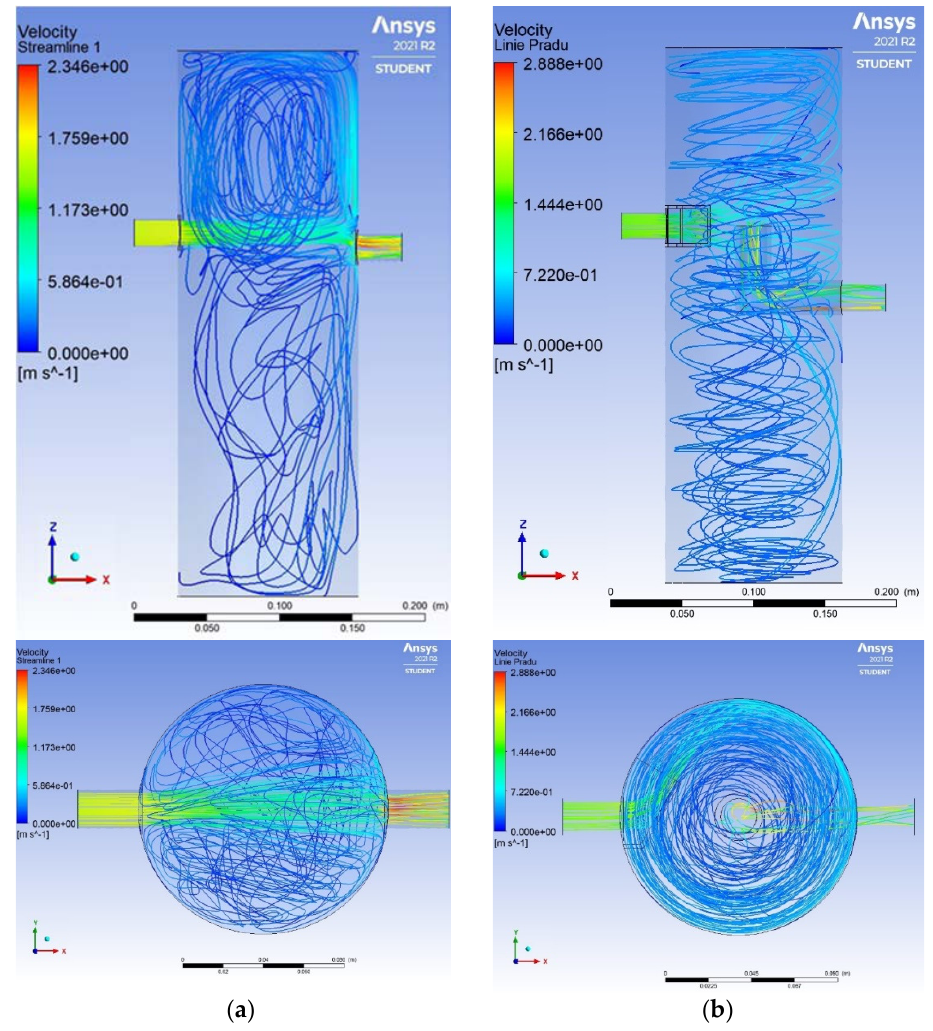
Figure 7. Velocity vector fields in the case of v 5 velocity for model: ( a ) OS, ( b ) OW.